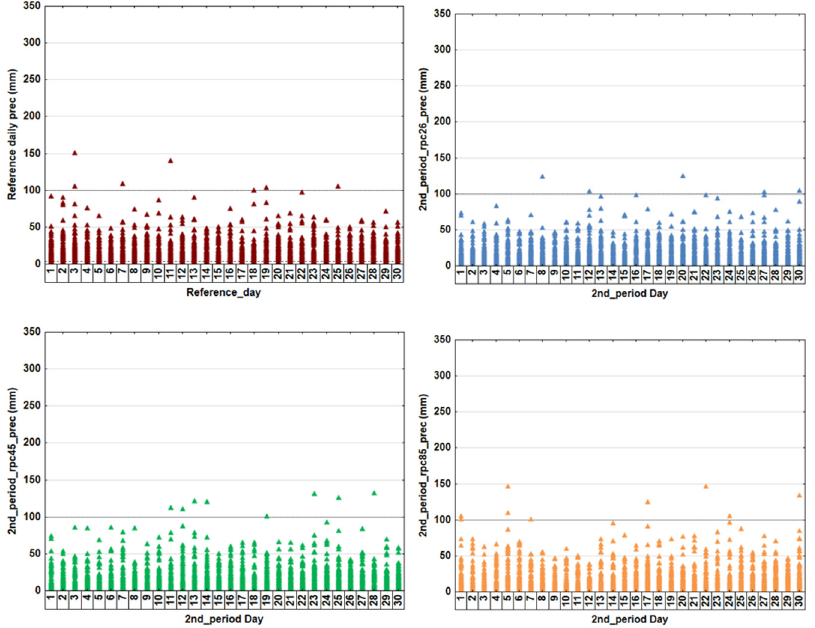
Figure 12. Fluctuations of daily precipitation values for the reference period and the climate scenarios of the second period. Dashed lines are reference lines for comparative purposes.